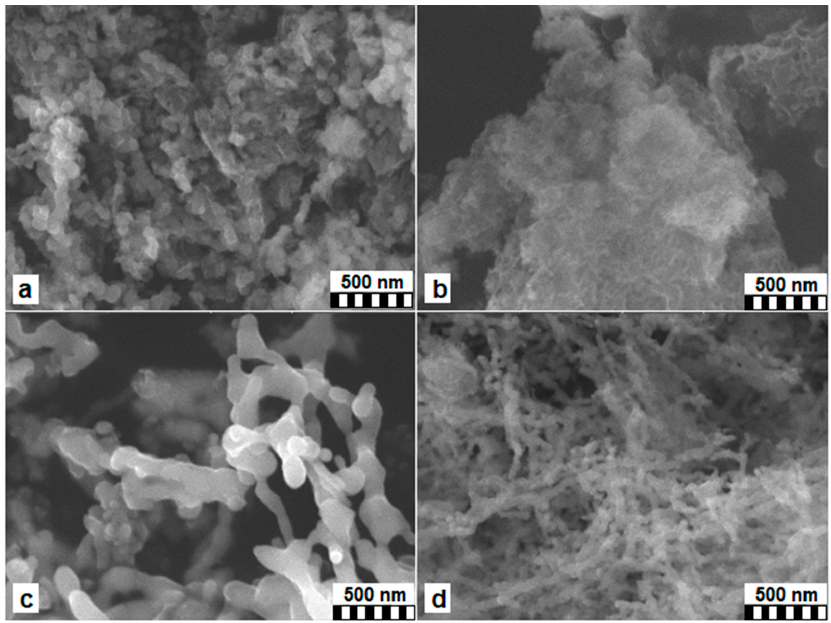
Figure 4. The scanning electron microscopy (SEM) images of nZVI produced from FeSO 4 ( a ), Fe(NO 3 ) 3 ( b ), FeCl 2 ( c ), FeCl 3 ( d